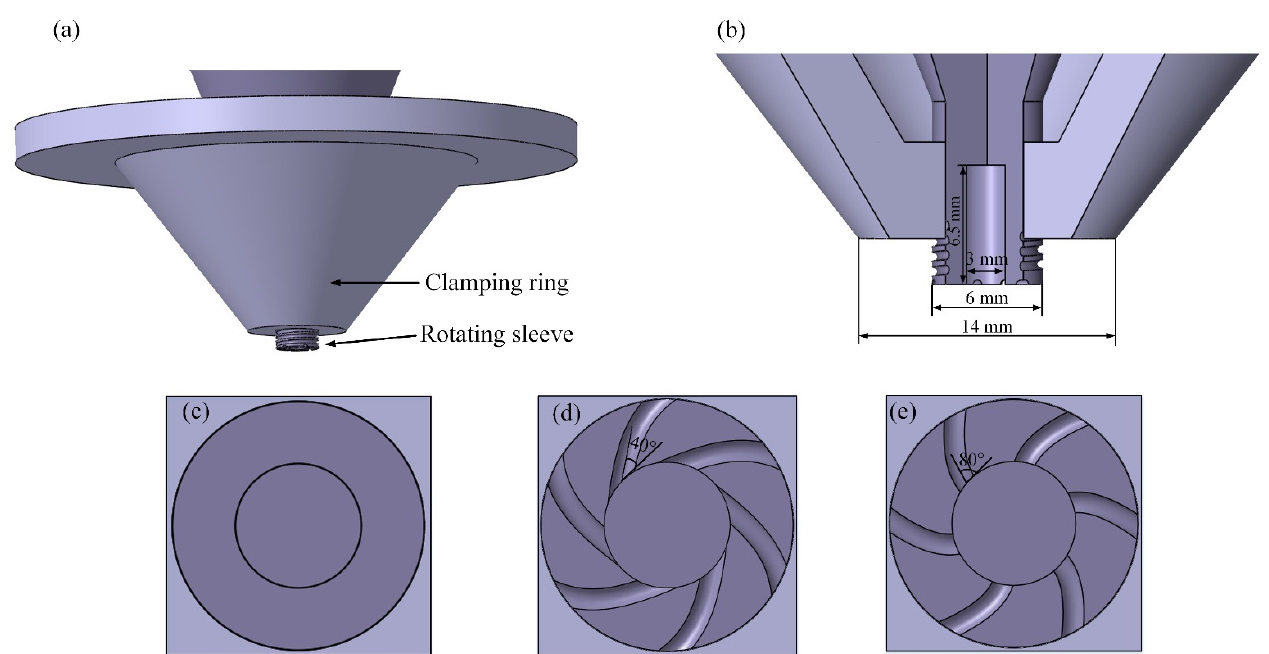
Figure 1. Simplified N-KFSW tool: ( a ) combination, ( b ) section; three different surface morphologies of the sleeve bottom: ( c ) RN sleeve bottom, ( d ) RF sleeve bottom and ( e ) RE sleeve bottom.